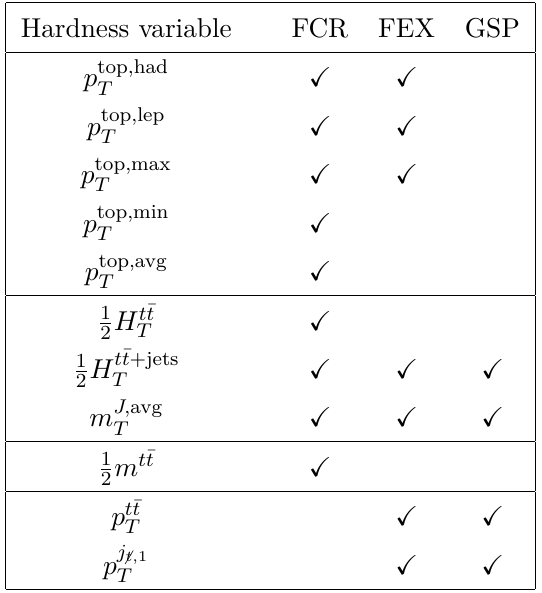
Summary of the topologies expected to contribute dominantly to the distributions of different hardness variables, when these are large relative to m for definitions of the hardness